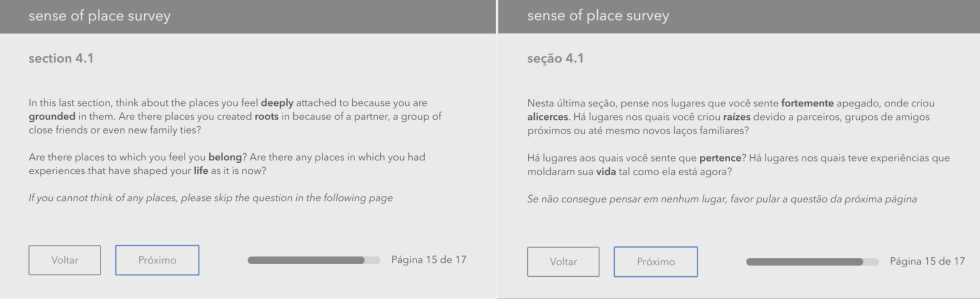
Figure 17: Introduction to place inherited section.